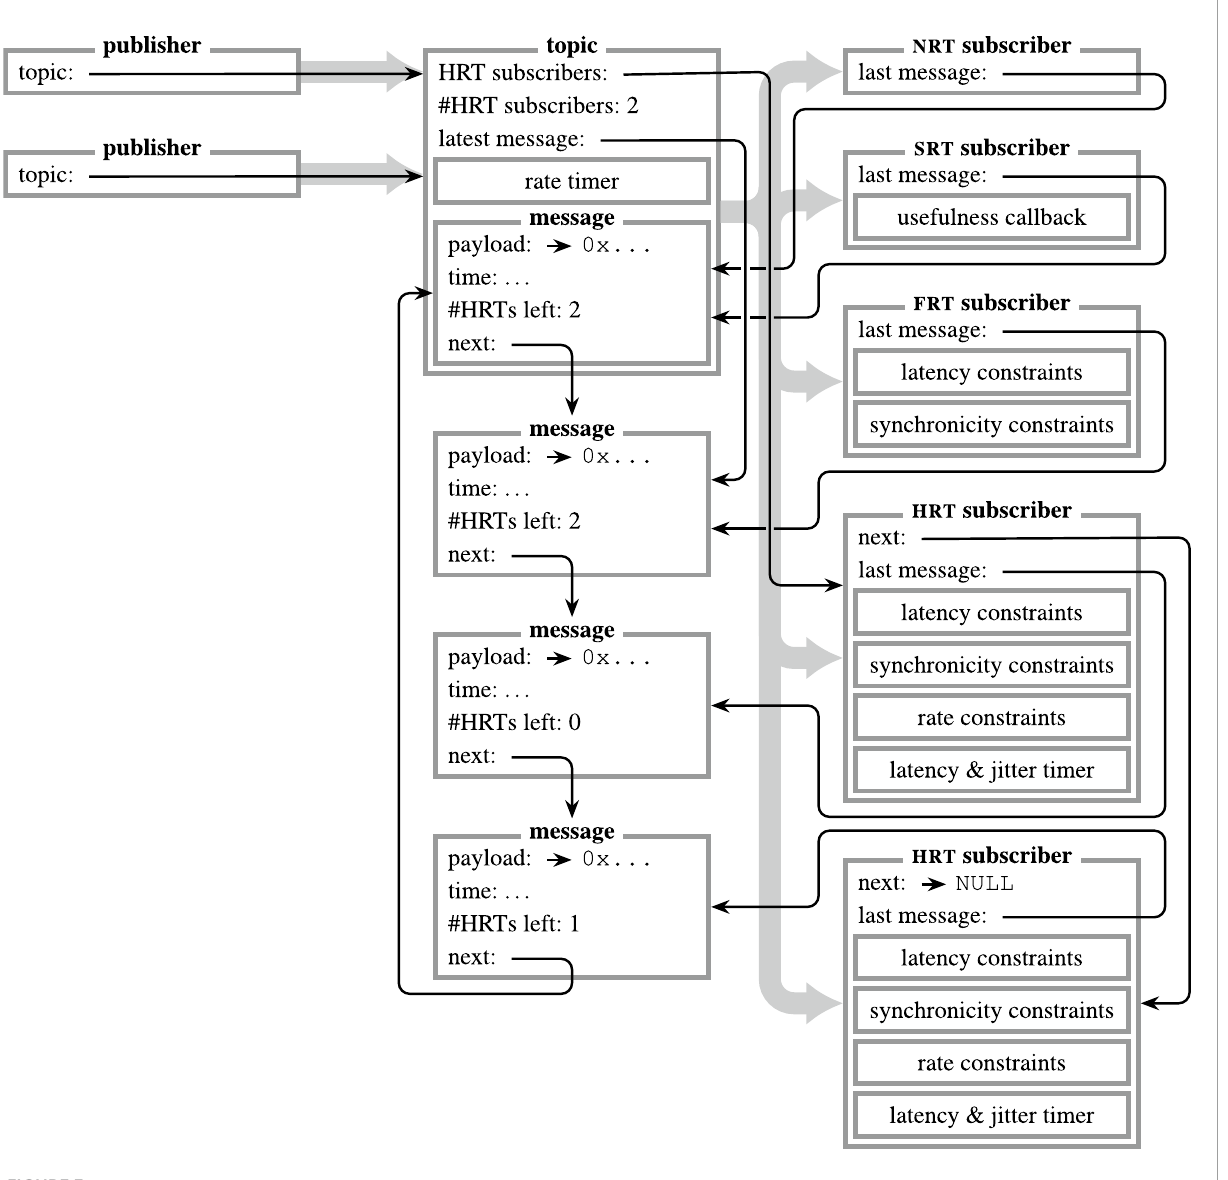
FIGURE 3 Visualization of a publish–subscribe interaction in µRT. Information is provided by an arbitrary number of publishers and passed via a topic to an arbitrary number of subscribers (